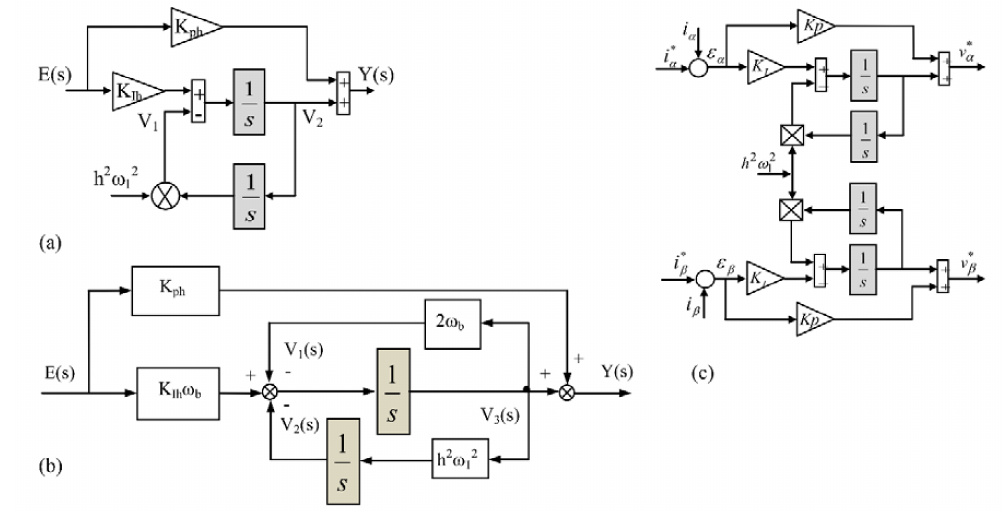
Figure 6. The block diagram of PR controller: ( a ) ideal controller; ( b ) non-ideal controller; and ( c ) controller considering both positive and negative sequence components in the stationary